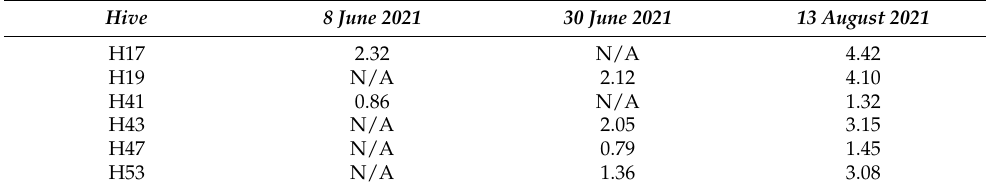
Table 11. Bee mass (kg) in monitored hives measured using the method in [9]; N/A—not applicable.